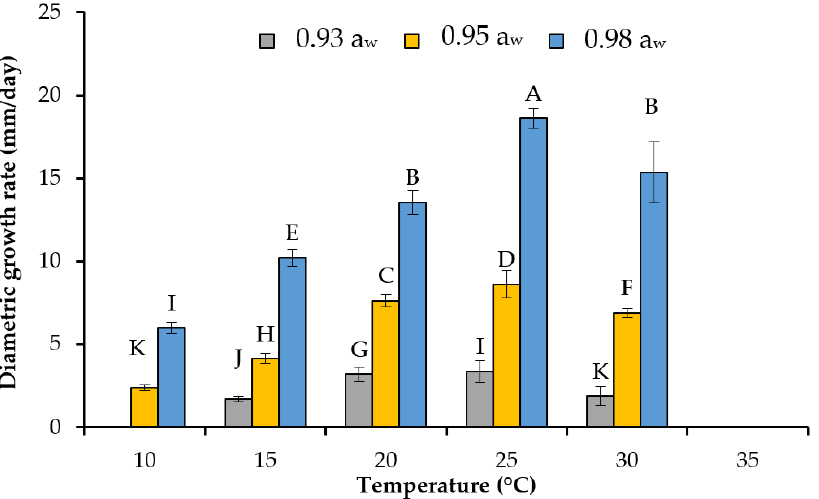
Figure 2. Effect of temperature at different steady state a w levels on the mean growth rate (mm/day) for the mean of the three strains of F. asiaticum (982, 082, Ch024b) on the wheat-based media. Vertical lines represent the standard deviation, and different letters indicate a significant difference between treatments.